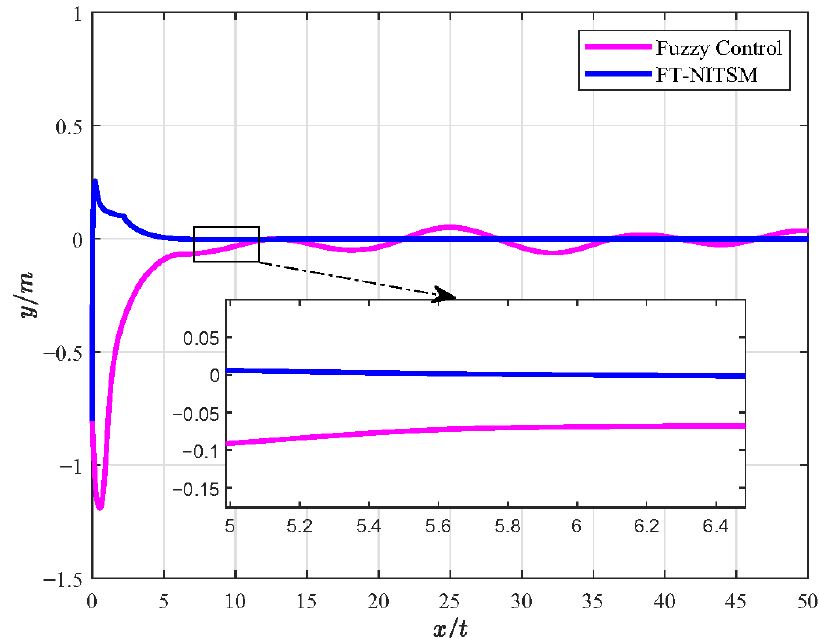
Figure 8. Comparison of error diagram of FT-NITSM tracking control and fuzzy control.